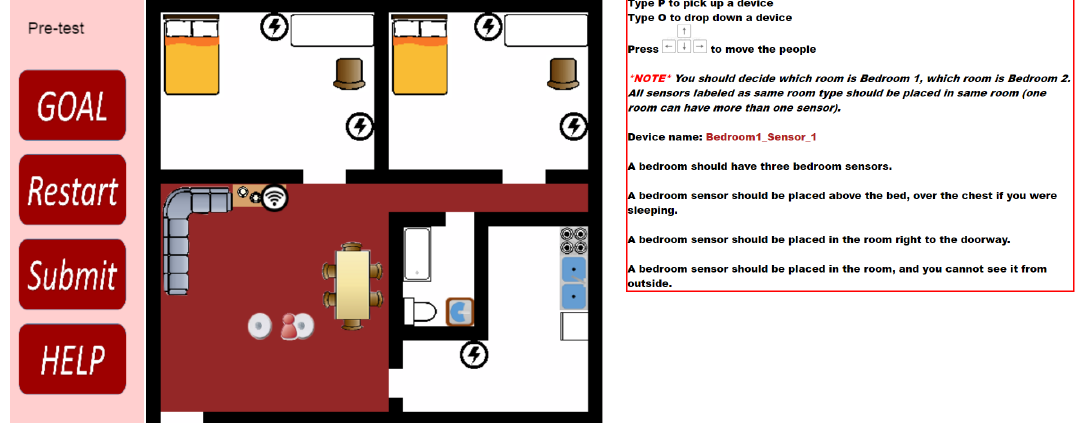
Figure 2. An example of SHiB CBLE user